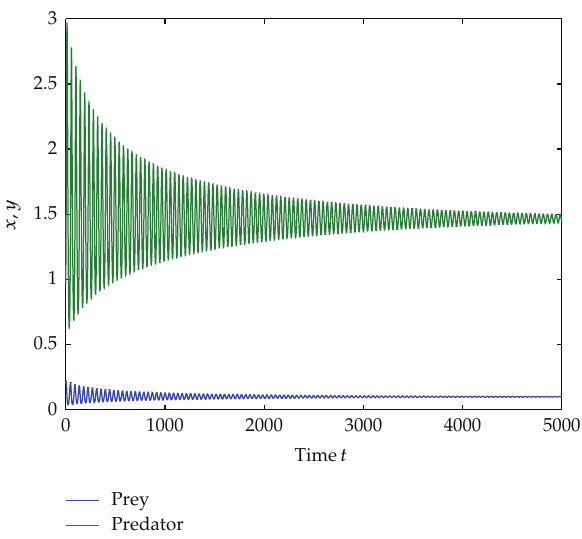
Figure 6: The positive equilibrium is stable when τ (cid:6) 3 > τ ∗ .